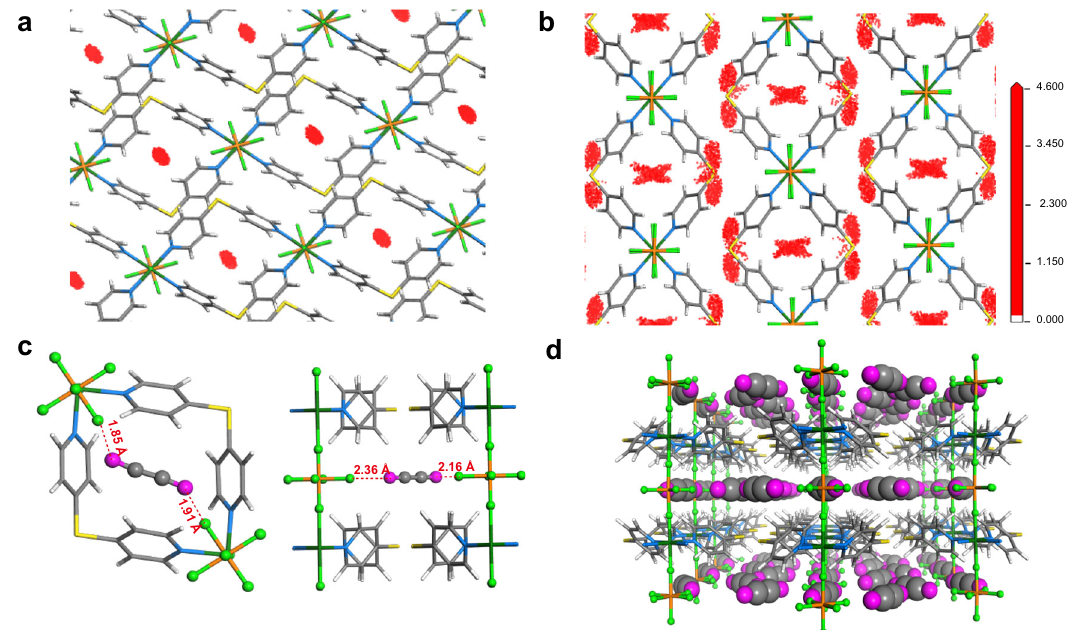
Fig. 3 Simulated density distribution of C 2 H 2 in SIFSIX-dps-Cu. C 2 H 2 distributions in SIFSIX-dps-Cu by GCMC simulation a at 1 kPa and b at 100 kPa and 298 K, viewed along the (CuSiF 6 ) ∞ chains. c DFT-D calculated C 2 H 2 binding mode in SIFSIX-dps-Cu. d Packing mode of C 2 H 2 -loaded SIFSIX-dps-Cu structure.